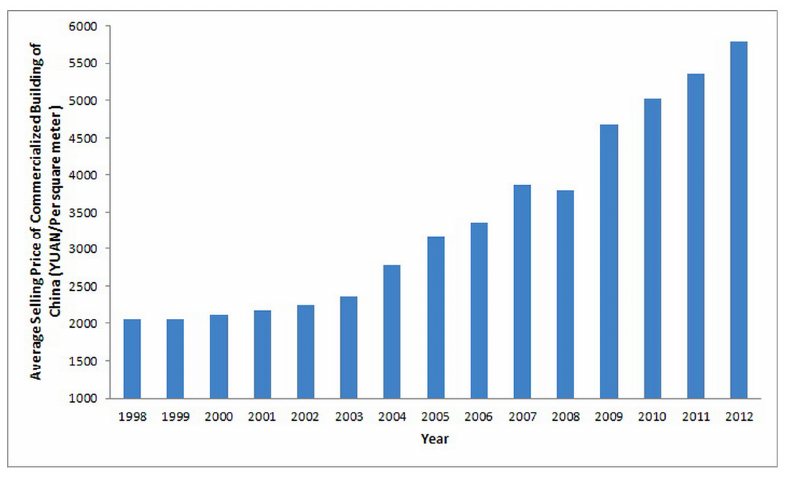
Figure 2. The average selling price of commodity housing in China between 1998 and 2012